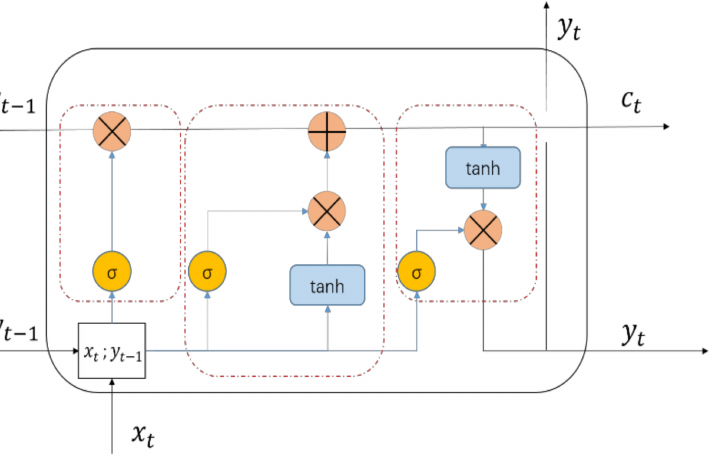
Figure A2. LSTM network structure.